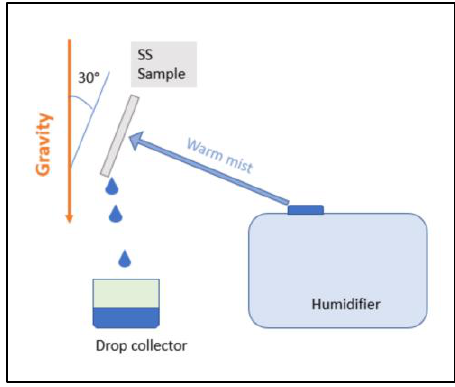
Figure 4: Experimental setup for condensation, droplet growth, and